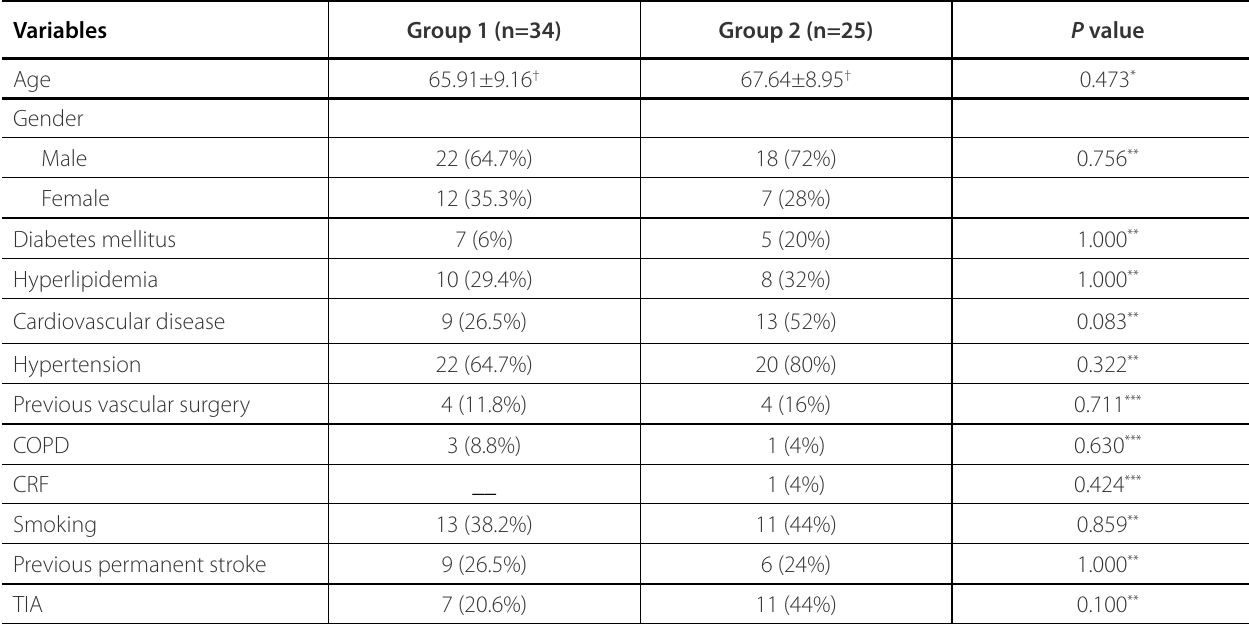
Table 1. Patient demographics.